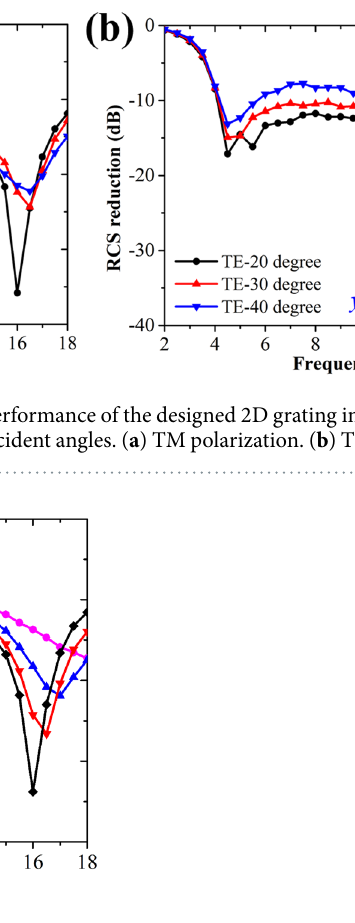
Figure 6. Simulated RCS reduction performance of the designed 2D grating integrated Salisbury screen with the different graphene